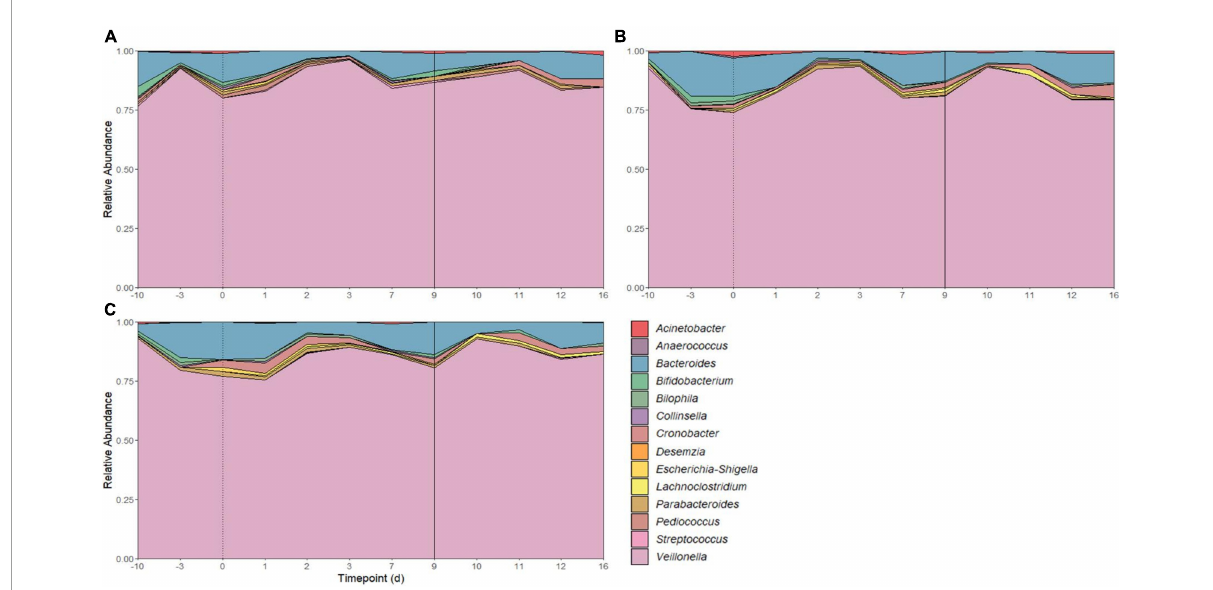
FIGURE6 Microbial community composition of SHIME 1 (A) , SHIME 2 (B) , and SHIME 3 (C) before and throughout the treatment period. Microbial composition shown as average relative abundance and colored by genera. Relative abundances were based on 16S rRNA gene sequencing of SHIME samples from the distal colon vessels. Days –10 and –3 indicate the time points before the start of the first treatment period, as shown by a dotted line on day 0. Day 9 indicates the start of the second treatment period (solid line).